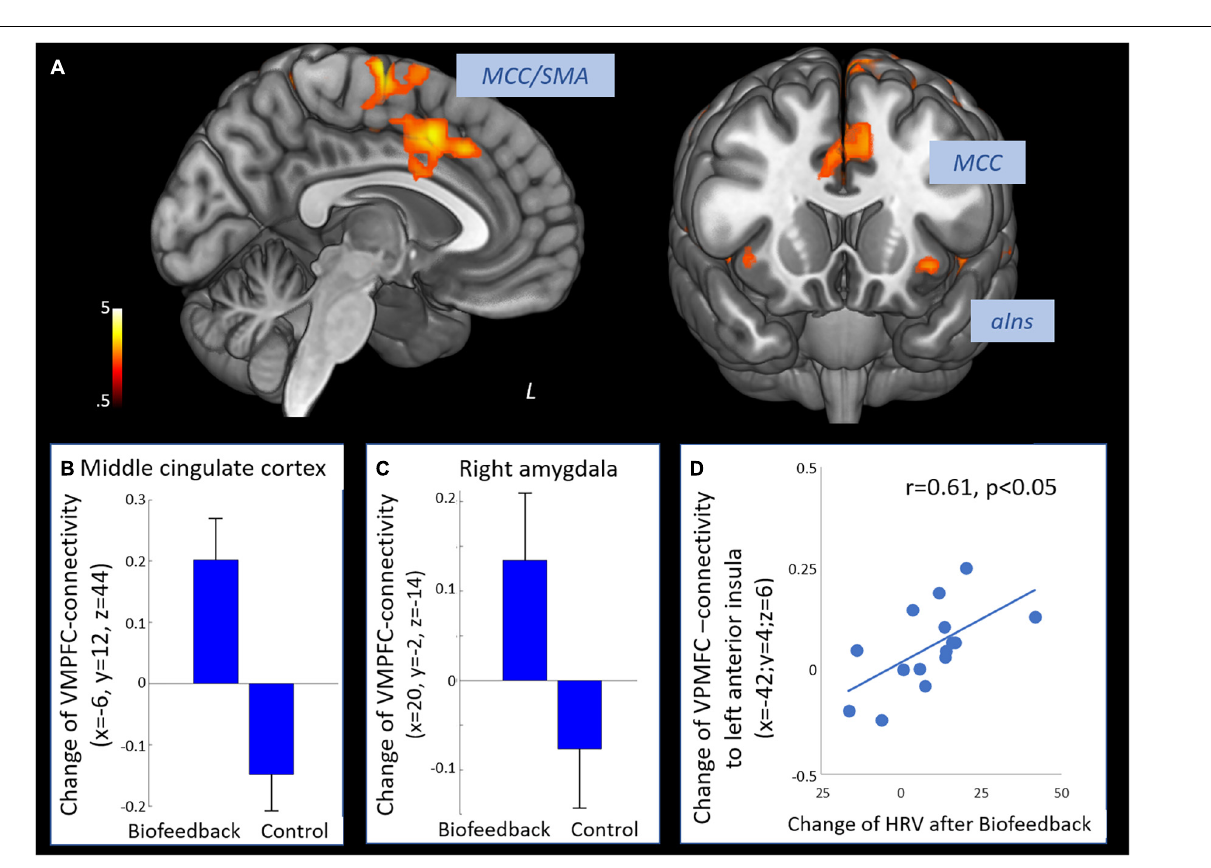
FIGURE 2 | Effect of biofeedback on functional connectivity of the prefrontal cortex. (A) Positive interaction contrast time × group revealing higher increases of functional connectivity of the VMPFC from T1 to T2 in the biofeedback group compared to the control group (voxel-level: p < 0.005 uncorr., cluster-level: p < 0.05 FDR-corrected). (B) Change of connectivity from T1 to T2 in the middle cingulate cortex. (C) Change of VMPFC-connectivity from T1 to T2 in the right amygdala. (D) Change of VMPFC-connectivity from T1 to T2 in the left anterior insula was correlated to the increase of HRV (Pearson r = 0.61, p < 0.05). SMA, supplementary motor area; MCC, middle cingulate cortex; aIns, anterior